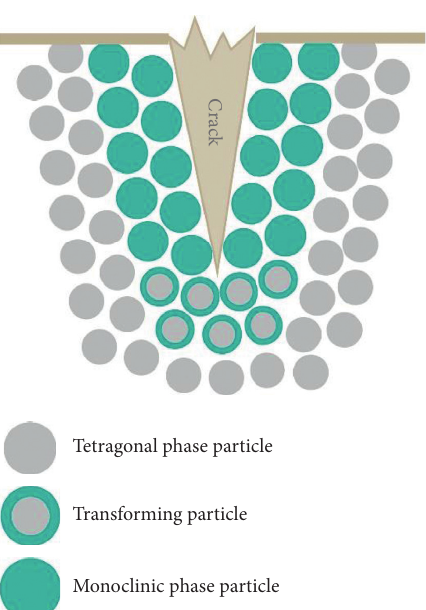
Figure 3: Transformation